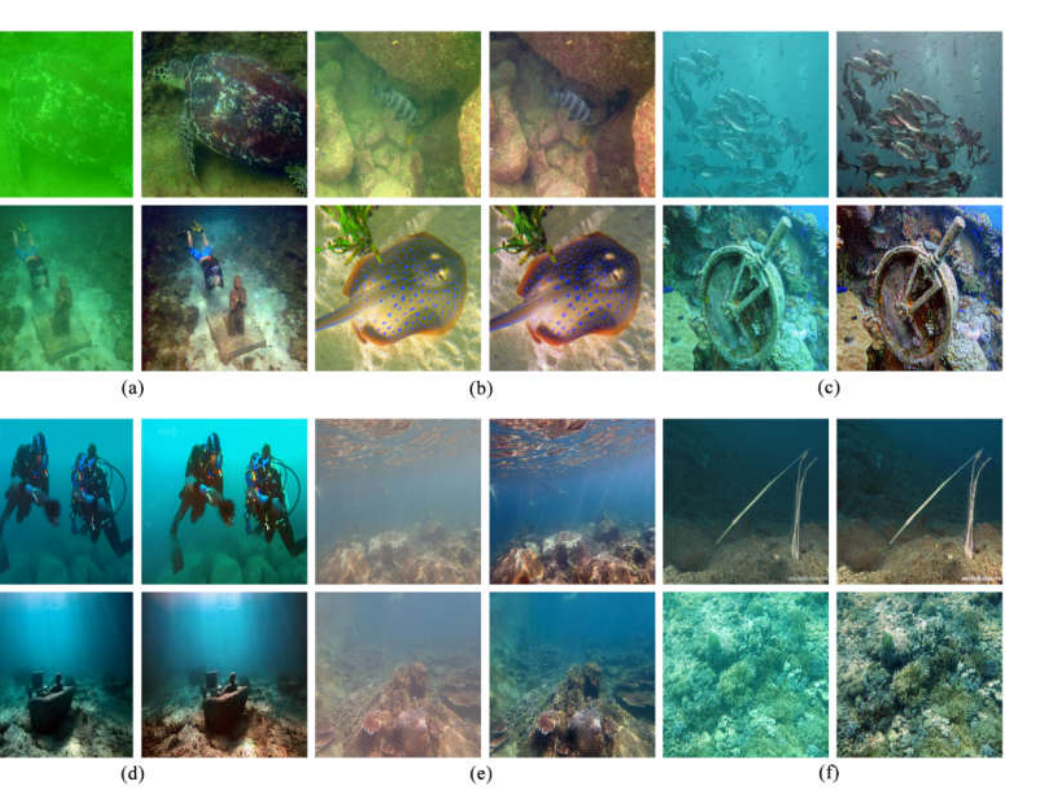
Figure 1. Different types of underwater images enhanced with UMGAN. Columns 1, 3, and 5 are turbid underwater images, while columns 2, 4, and 6 are corresponding images enhanced by UMGAN. ( a ) Greenish images. ( b ) Yellowish images. ( c ) Blueish images. ( d ) Low-light images. ( e ) Images with white fog. ( f ) Low-contrast images.